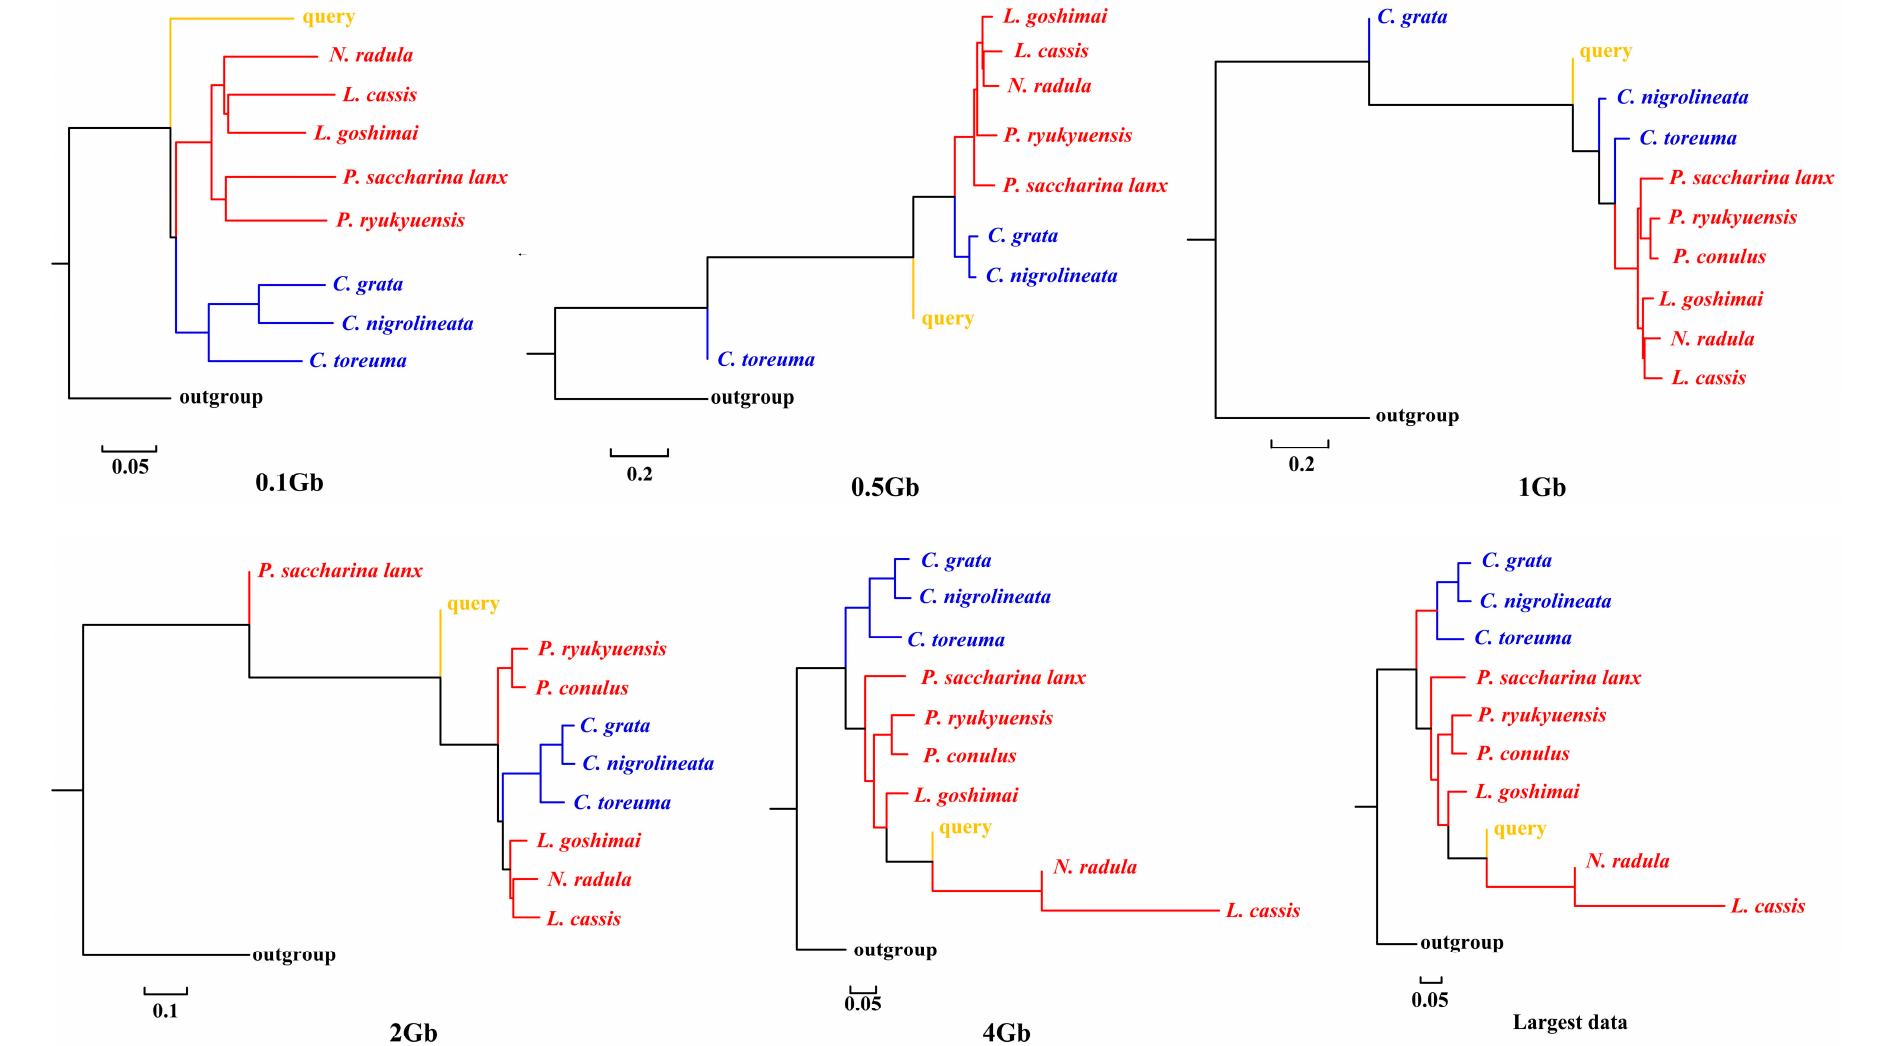
Figure 3. Phylogenetic placement of S. flexuosa (query species) under different sizes of genome skims.